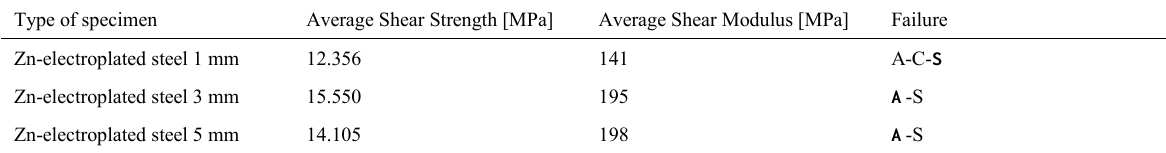
Table 2: Reference set of specimens with Zn-electroplated steel.